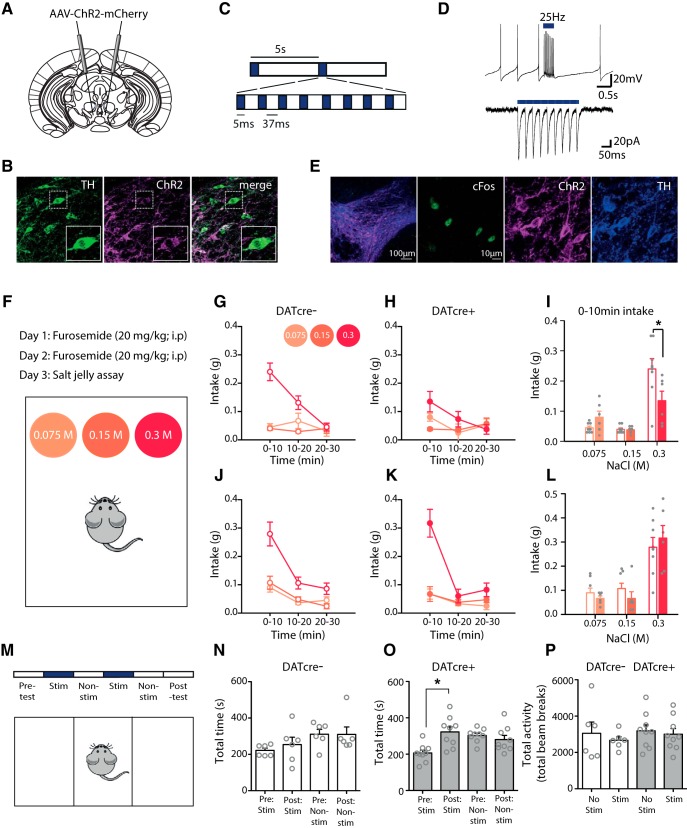

Optogenetic excitation of VTA dopamine neurons selectively decreases intake of high-concentration salt jellies during salt appetite. A, DATcre- and DATcre+ mice were injected with a cre-dependent AAV carrying ChR2, conjugated to the fluorescent protein mCherry (AAV-ChR2-mCherry). B, Colocalization of mCherry and TH confirmed expression of ChR2 in VTA dopamine neurons in DATcre+ mice. C, Optical stimulation consisted of eight pulses: 5 ms on of a blue light laser, 37 ms off. D, Ex vivo whole-cell patch recordings confirmed the optical blue light stimulation protocol was sufficient to depolarize the VTA TH+ positive cells leading to phasic bursts of activity. E, DATcre+ (n = 4) and wild-type litter mates (n = 3) injected with AAV-ChR2-mCherry in the VTA were optogenetically stimulated using the same protocol. A significant increase in the number of dopamine neurons exhibiting cFos expression was observed in DATcre+ mice compared to DATcre- mice [23.1 ± 3.6 vs 12.9 ± 1.5; t = 2.326, p = 0.028; N = 16 and 12 (sections); immunostaining for tyrosine hydroxylase (TH) and cFos], confirming VTA dopamine neurons were activated in vivo by optical blue light stimulation. F, An acute salt appetite was induced and assayed by injecting mice with the diuretic furosemide for 2 d before a preference test between three jellies of three different NaCl concentrations. DATcre- and DATcre+ mice were optogenetically stimulated with blue light during the preference test. DATcre- (n = 8; G) and DATcre+ mice (n = 6; H) differed in their intake of the different concentration salt jellies, time × genotype × concentration F(4,48) = 3.6, p < 0.05. Main effects of time F(2,24) = 10.3, p < 0.005, concentration F(1.5,18.2) = 9.4, p < 0.005 and time × concentration F(2.5,30.4) = 18.4, p < 0.001) were also revealed with statistical analysis. There was no significant interaction of time × genotype (F(2,24) = 1.7, p > 0.1, N.S.). I, A selective reduction in intake of the high-concentration salt jelly occurred during the first 10 min of the test session in the DATcre+ mice, concentration × genotype F(2,24) = 7.1, p < 0.005, concentration F(1.5,17.6) = 34.11, p < 0.001, pairwise comparisons 0.3 M salt DATcre- vs DATcre+ *p < 0.05. J, K, When tested a week later in the absence of stimulation, mice preferentially consumed the highest concentration salt jelly (concentration F(1.3, 16.1) = 40.6, p < 0.001). Overall, mice decreased their consumption across time (F(1.7,20.0) = 56.4, p < 0.001) presumably due to satiation which resulted in an overall change in preference for the high-concentration salt jelly (time × concentration F(2.5,30.1) = 16.4, p < 0.001). No differences in intake were observed between salt-depleted groups across the session (time × genotype × concentration F(4,48) = 1.7, p > 0.1, N.S., concentration × genotype, time × genotype, and genotype all F < 1, p > 0.5, N.S) (L) nor during the first 10 min of the session (genotype, concentration × genotype all F <1, p > 0.3). M, DATcre- (n = 9) and DATcre+ (n = 6) mice injected with the cre-dependent AAV-ChR2-mcherry virus in the VTA and were tested using an biased CPP test. Preference was assessed for one of two chambers (pre-test) followed by optogenetic stimulation for 2 d in the non-preferred chamber (days 2 and 4) and 2 d of no stimulation in the preferred chamber (days 3 and 5). The last day (post hoc test), mice were tested for their preference in the absence of stimulation. N, DATcre- mice (n = 6) showed no preference for the chamber where they had previously received stimulation (stimulation F(1,5) = 2.9, p > 0.1, N.S.; session F(1,5) = 2.6, p > 0.1, N.S.; session × stimulation F < 1, p > 0.7, N.S). O, DATcre+ mice (n = 9) showed a significant preference for the chamber in which they had previously received stimulation (session × stimulation F(1,8) = 7.0, p < 0.05), pairwise comparisons revealed this was specific to the stimulated chamber (pre- vs post-session *p < 0.01). P, Optogenetic stimulation did not change locomotor activity as measured during the stimulation days of the unbiased CPP test (stimulation; stimulation × genotype; genotype all F < 1, p > 0.4, N.S.). Data represented as mean ± standard error of the mean (SEM).